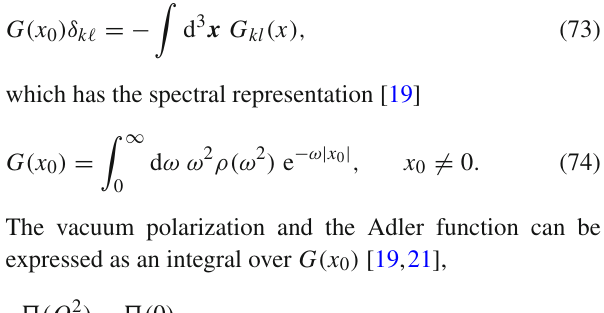
where ˆ x 0 = m μ x 0 . Here γ E = 0 . 577216 .. is Euler’s